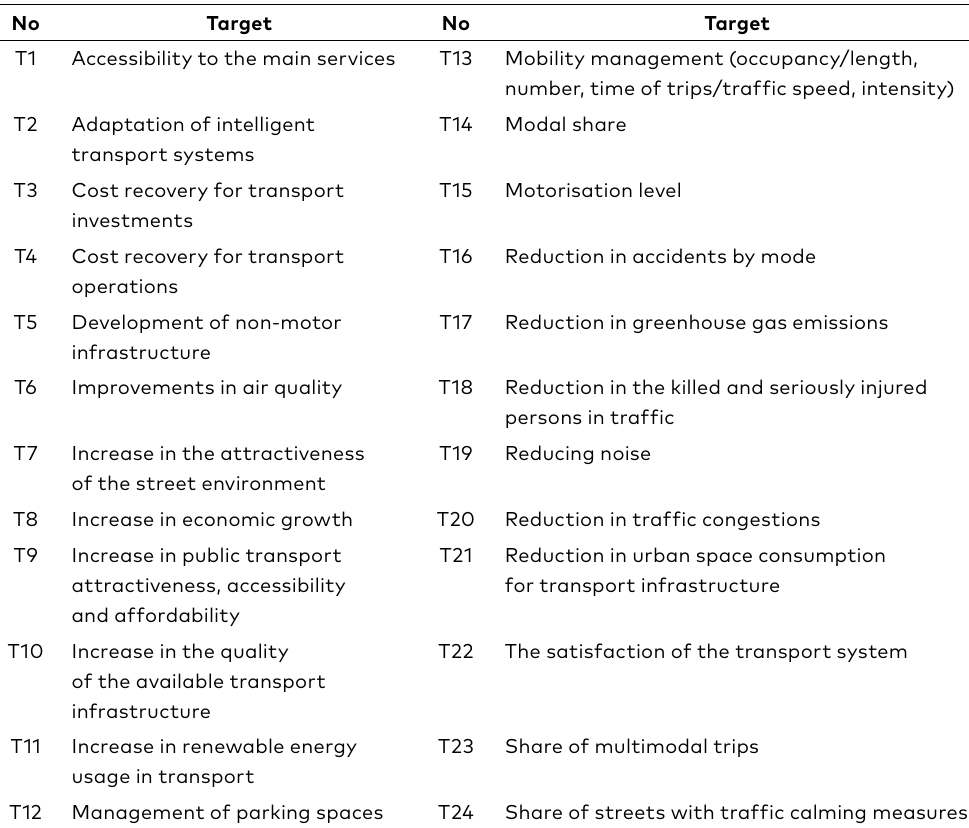
Table 3. Targets for monitoring and